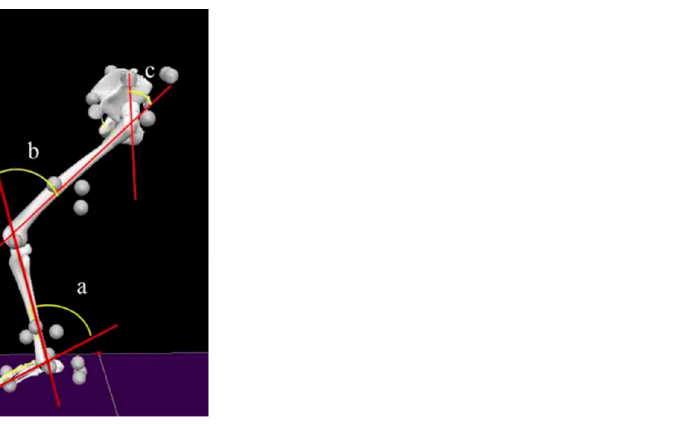
Figure 1. Placements and joint angles of the pelvis, thigh, shank, and foot: (a) angle of the ankle, (b) angle of the knee, (c) angle of the hip.